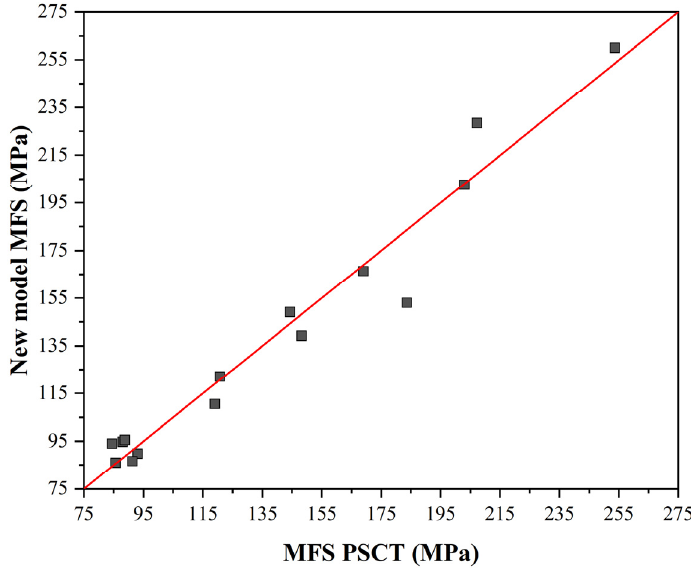
Figure 20. Comparison of measured and calculated MFS values according to Equation (10).